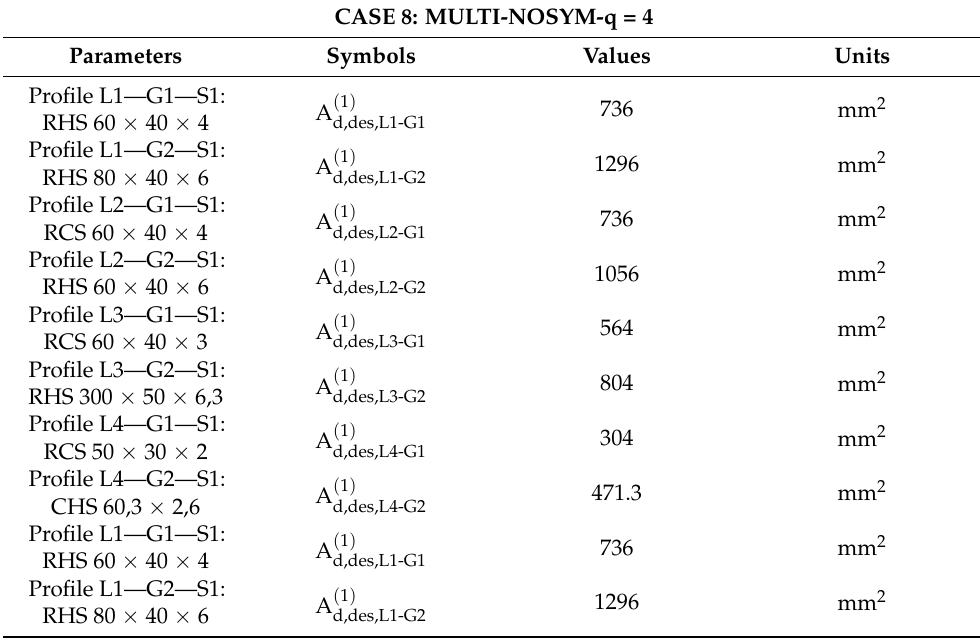
Table 20. Results of case study 8 (L: level; G: group; S: step).